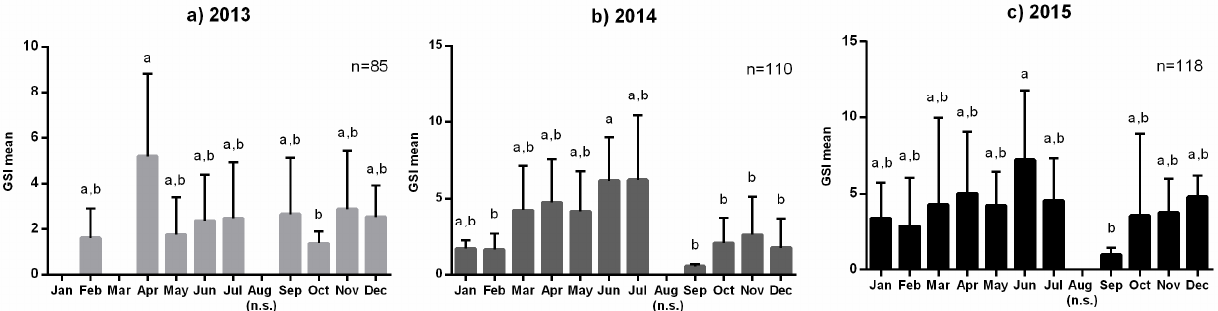
Figure 2. Monthly variation of European hake female gonadosomatic index (GSI) for three years. Statistical differences were described in the result section. In January and March of 2013, no mature females were found. In August of the three years, no samples (n.s.) were sampled. The letters indicate a statistically significant difference among groups ( p < 0.05) determined by Tukey’s multiple comparison test.